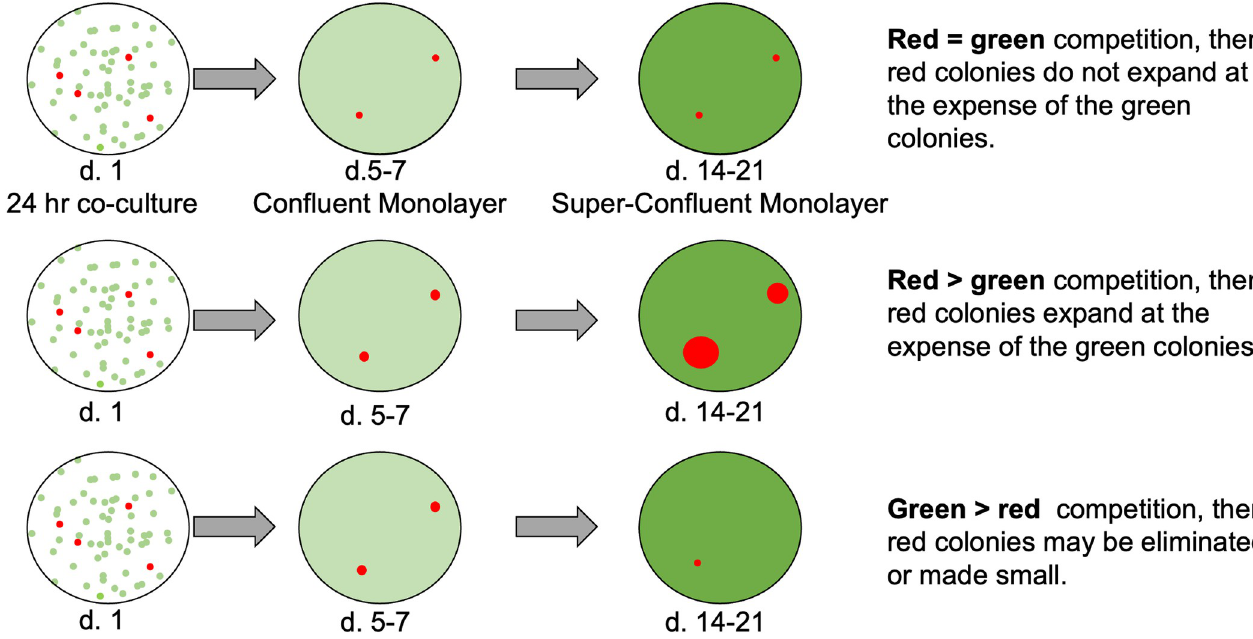
Fig 1. An assay for enhanced competition by papillomavirus infected cells. Keratinocytes were labeled by lentiviral transduction with either green (eGFP) or red (Fusion Red) proteins and then transduced with either vector or papillomavirus expressing retroviruses and cultured separately. On day 1 of the assay, 99.9% vector-expressing green cells and 0.1% oncogene expressing red cells are mixed and plated together at 10% confluency in a 10 cm dish. 24 hours later, those co-plated cells are trypsinized and each sample was plated onto 3 glass coverslips in a 6 well plate (2.1 10 4 cells / cm 2 ). Cells reach confluency by day 5–7 at which point one well is fixed and a second well is fed with F-media for another 7 days and then fixed, and a third well incubated for another 7 days before fixation and staining with DAPI. Pictures of fluorescent colonies are taken with a 4X objective from randomly selected fields and the relative size of the colonies ascertained using NIH ImageJ